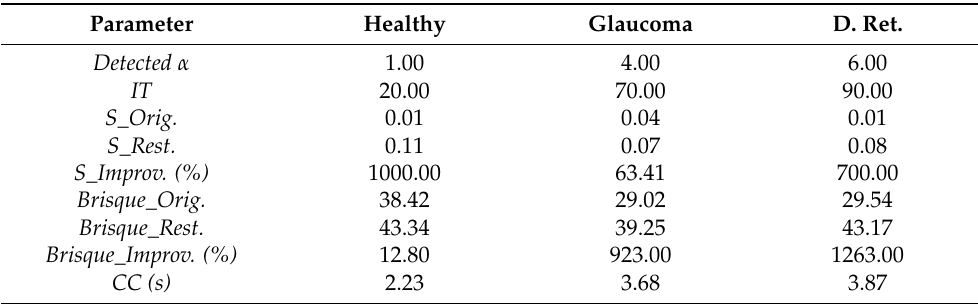
Figure 10. Original image from a healthy subject. ( a ) Edge segmentation of original image. ( b ) Re- stored image ( c ) and edge segmentation of restored image ( d ). Table 2. Results of the deconvolution processing in real retinal images. Detected glare angle: (Detected α ). Optimal iteration number (IT). Sharpness of the original image (S_Orig.). Sharpness of the restored image (S_Rest). BRISQUE (see Section 2.2.4) of the original image (BRISQUE_Orig.). BRISQUE of the restored image (BRISQUE_Rest). Computational costs